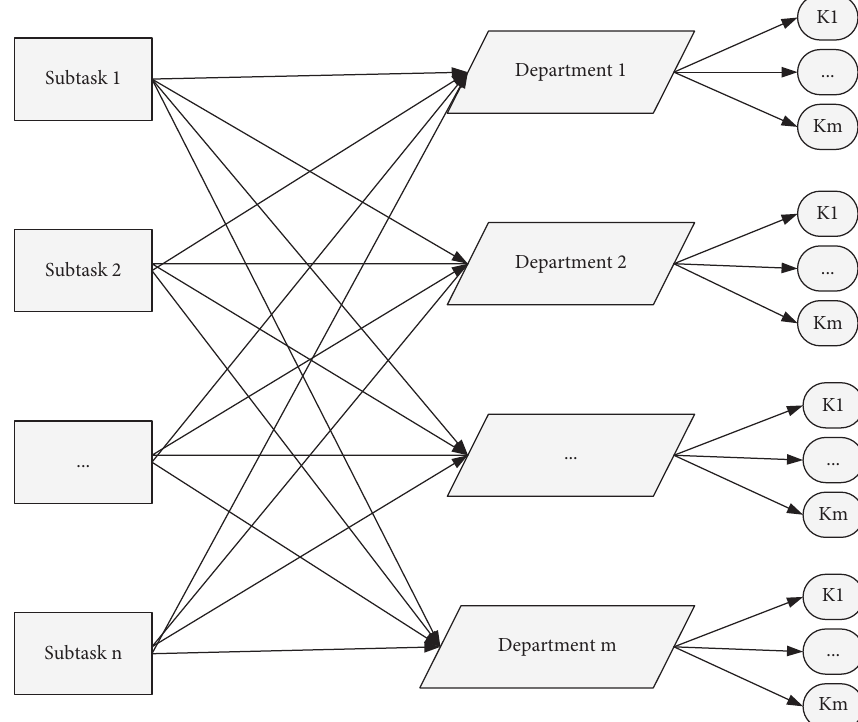
Figure 5: Mapping diagram of task and department